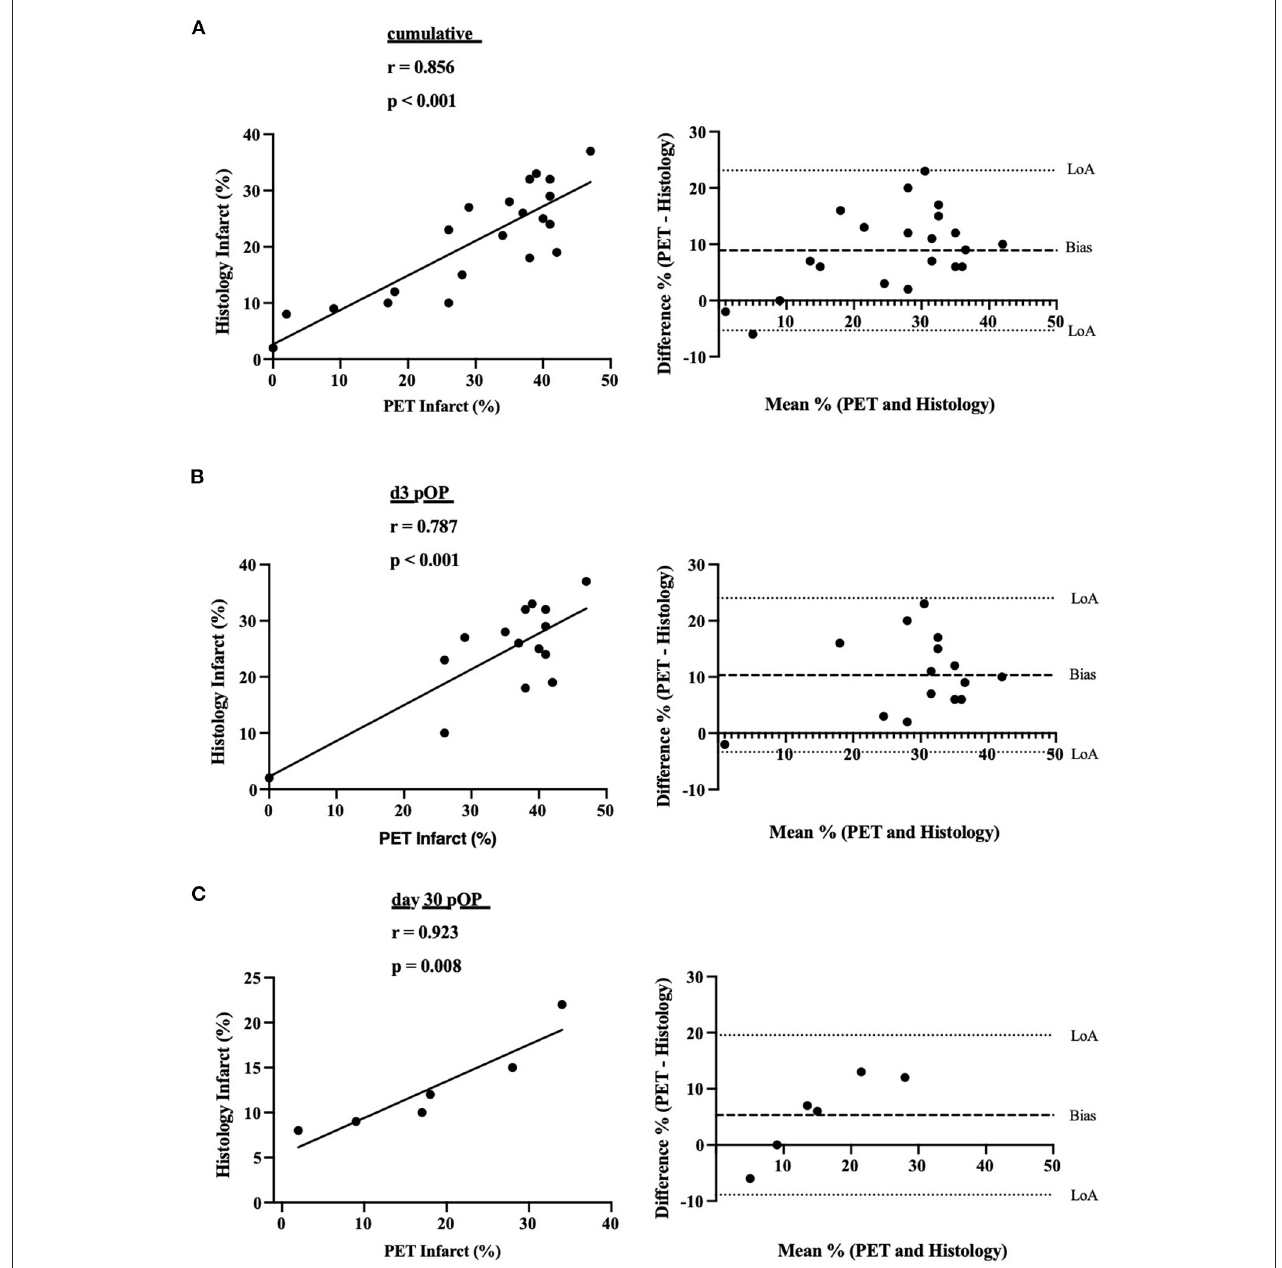
FIGURE 2 | Scatter plots of the correlation between histological and PET infarct areas. (A) Cumulative correlations between histological and PET infarct area (in %). Corresponding Bland-Altman-plot on the right side. Dotted lines display the Limits of agreement (LoA) and correlation line. Dashed lines indicate bias. (B) Correlations between histological and PET infarct area (in %) at day 3 post-MI. Corresponding Bland-Altman-plot on the right side. (C) Correlations between histological and PET infarct area (in %) at day 30 post-MI. Corresponding Bland-Altman-plot on the right